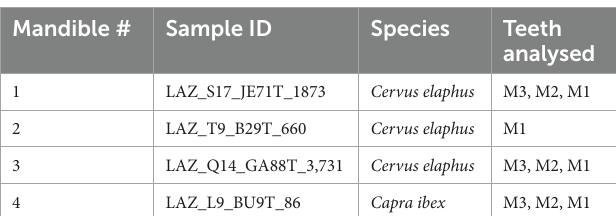
TABLE 2 Lazaret Cave red deer and ibex sample information including preserved teeth and teeth analysed for 87 Sr/ 86 Sr and δ 18